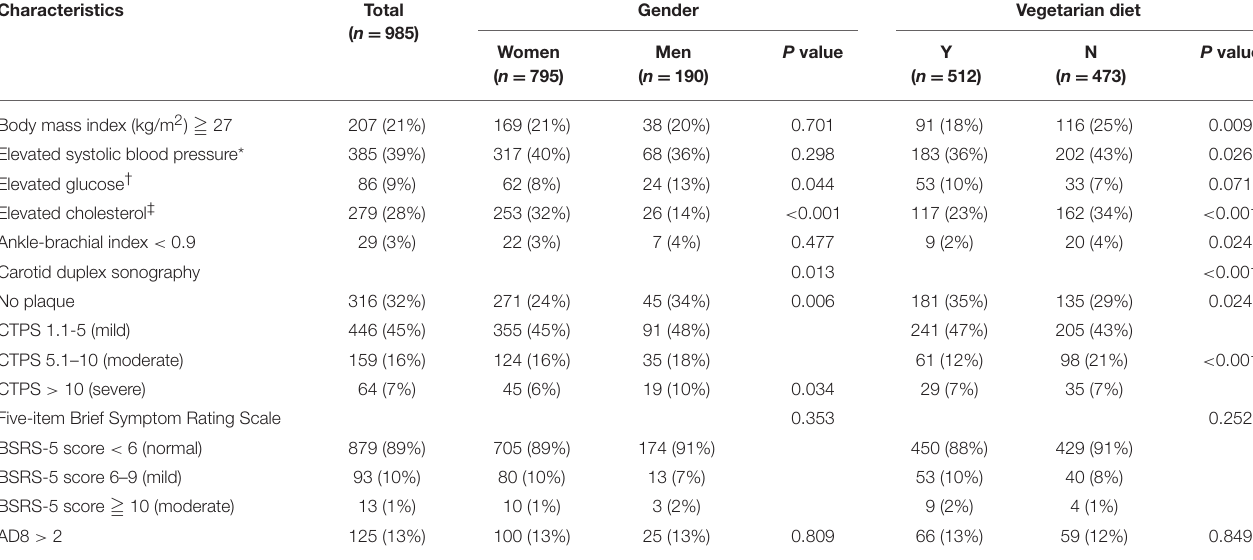
TABLE 3 | Results of vascular, cognitive, and psychomental survey in 985 volunteers.